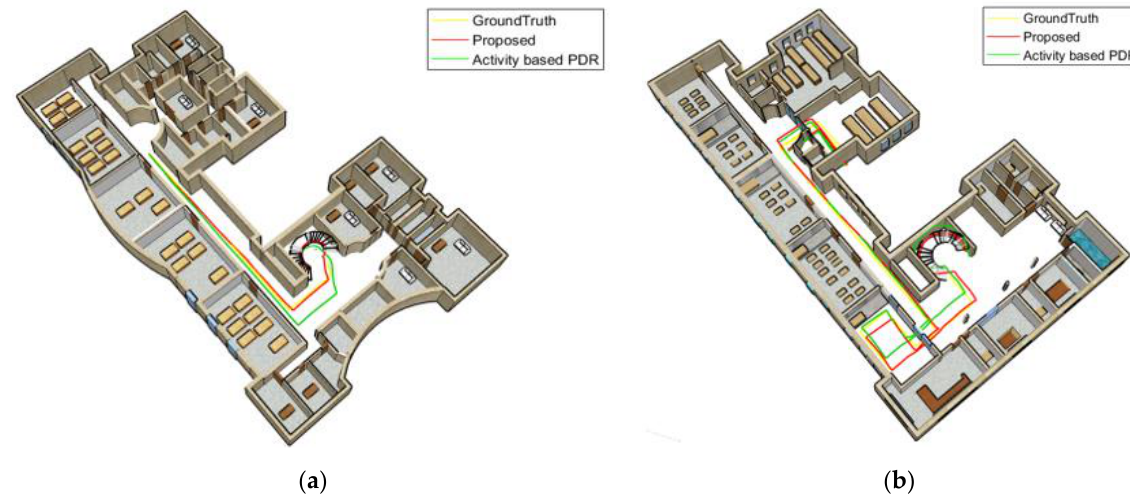
Figure 21. A calling woman; ( a ) third floor; ( b ) first floor.